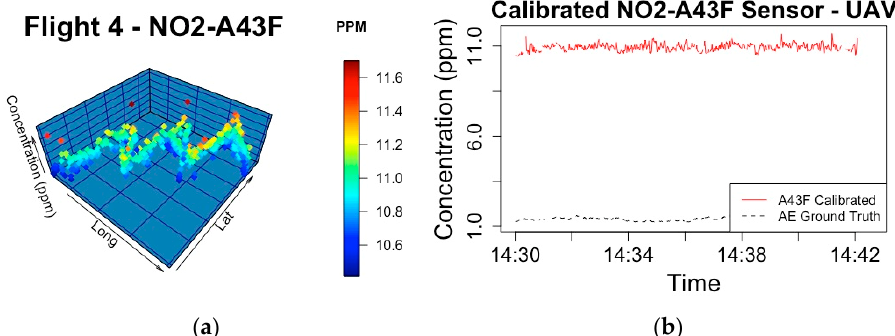
Figure 5. Comparing NO 2 concentration for the calibrated NO 2 -AE sensor using the best model where rotor speed is used, and the second-best model, where rotor speed is not used. The RMSE is indicated as error bars for each data point.